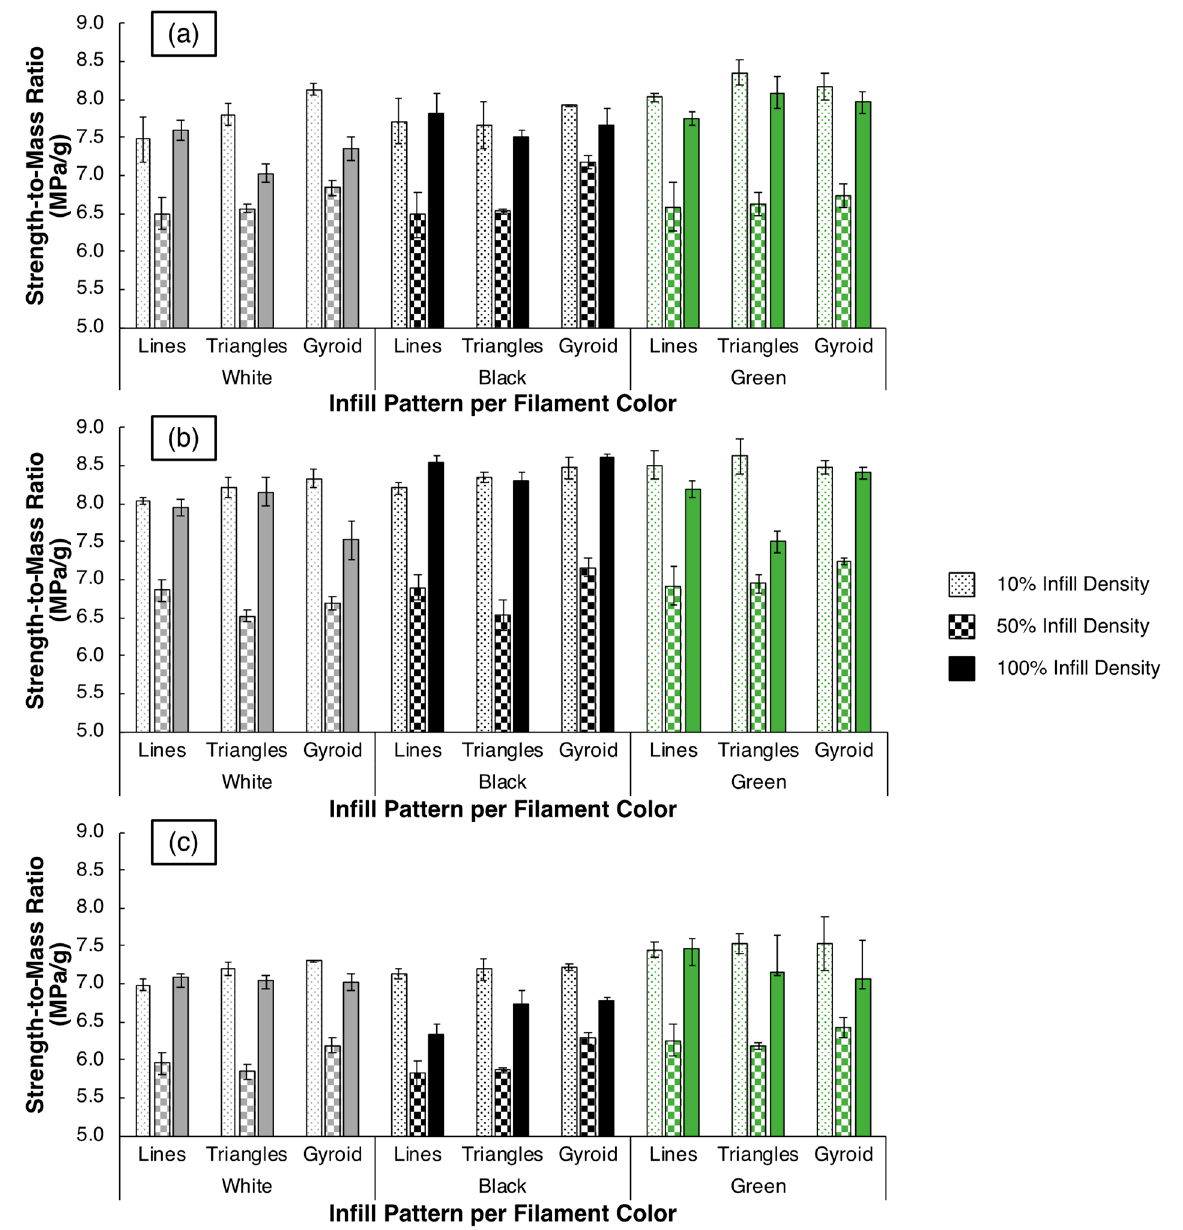
Figure 5. Average strength-to-mass ratio ( σ UTS ) values at each infill density, infill pattern, and filament color for the ( a ) OVERTURE, ( b ) SUNLU, and ( c ) HATCHBOX specimens with differences in bar color delineating the filament color and differences in the bar pattern delineating the specimen infill density.